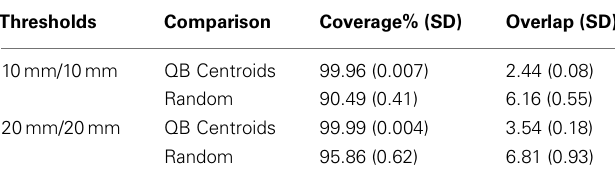
Table 1 | QB centroids performance compared with random subsets.